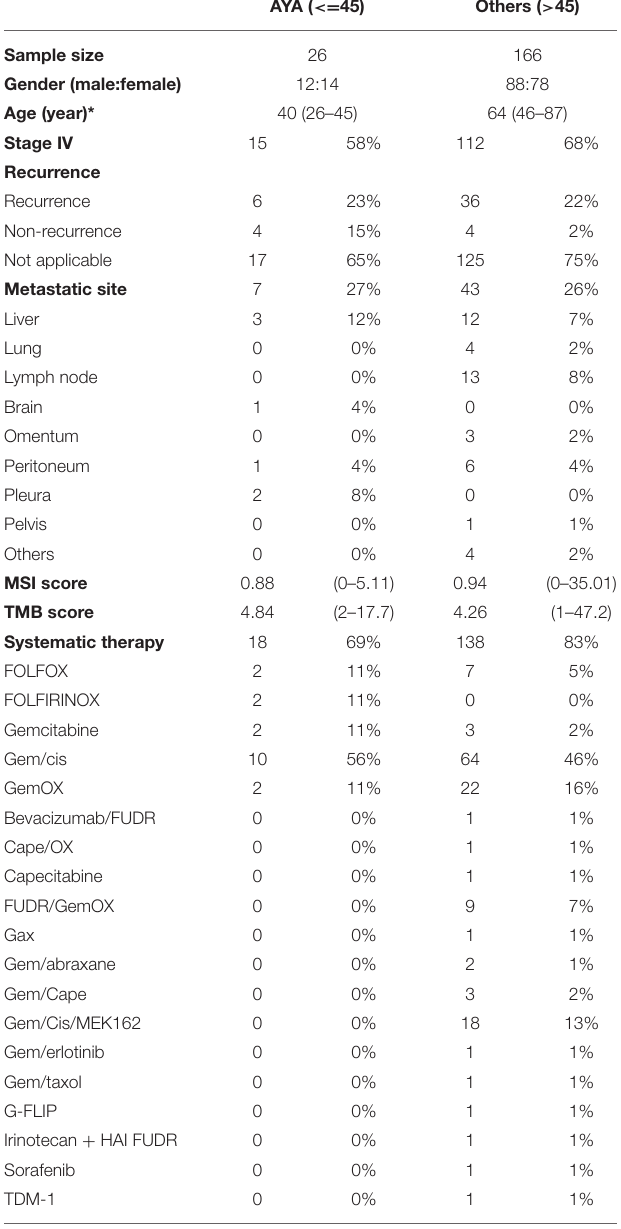
TABLE 1 | The clinical character of AYA patients and older patients. AYA ( < = 45) Others ( >